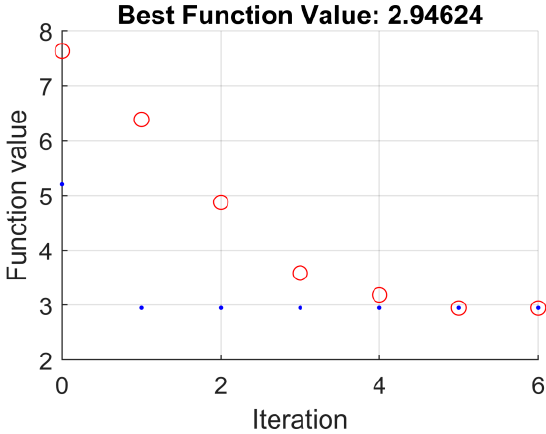
Figure 14. Transients of motor, load and reference speed for analyzed controller cases.